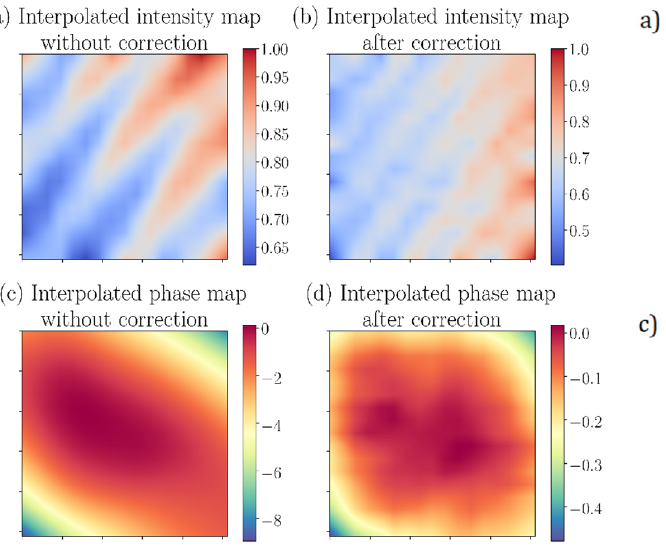
Fig. 7. Top: intensity maps, before and after correction, scaled by the DMD normalized intensity. Bottom: phase maps before and correction, scaled by the path difference divided by the laser wavelength. The width of the images is 800 pixels (10.9mm).